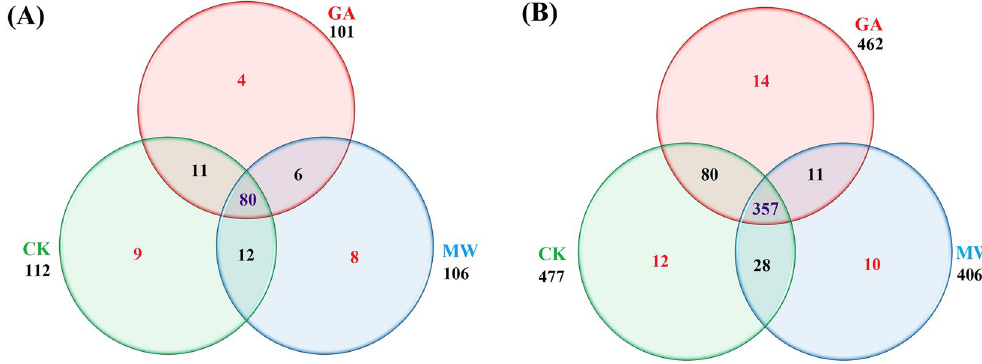
Figure 2. Venn diagrams showing the number of conserved ( A ) and novel ( B ) miRNAs expressed in the geometrid-attacked (GA), mechanical-wounding (MW) and control samples (CK). A: conserved miRNAs, B: novel miRNAs.